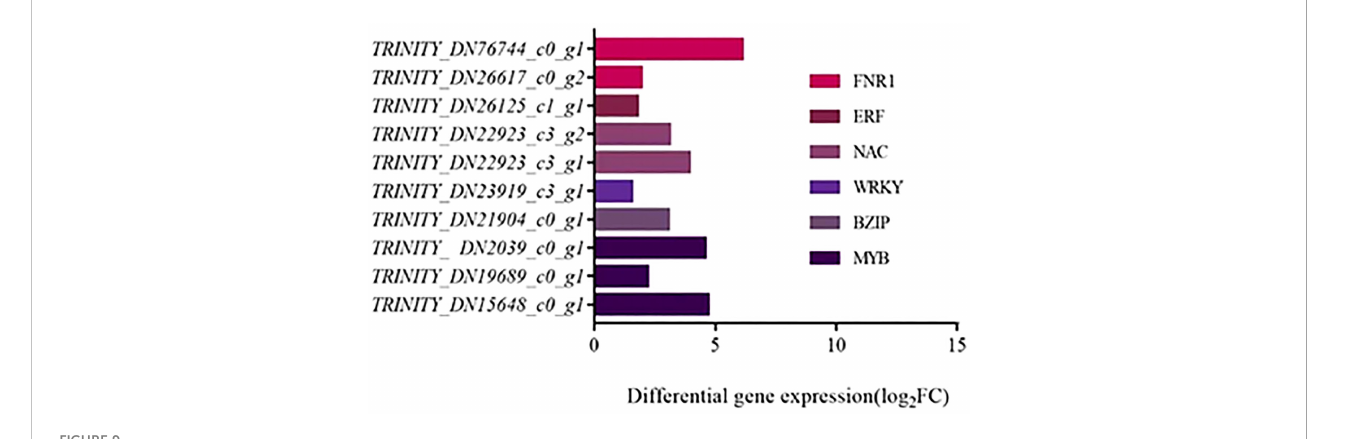
FIGURE 9 Transcription factors with differential expressions and their corresponding